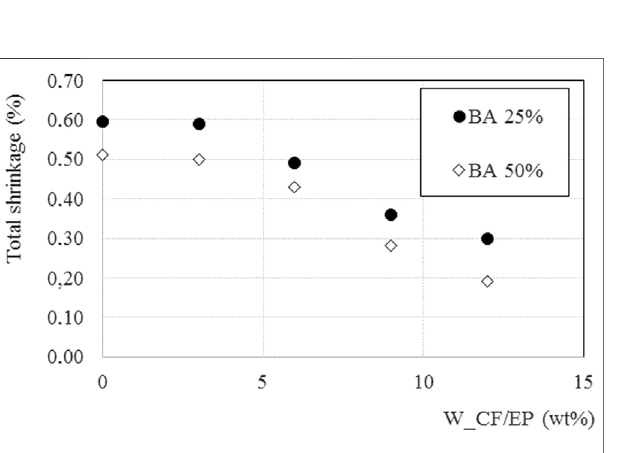
Frontiers in Materials |